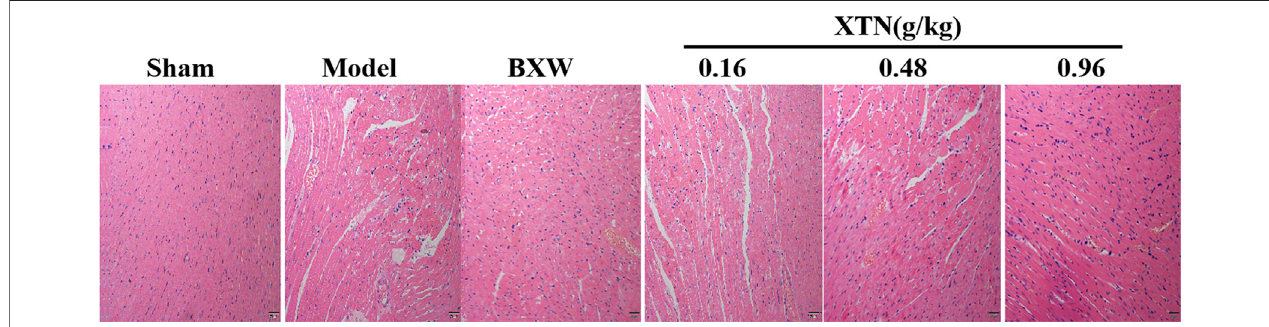
FIGURE 6 | Results of HE staining for cardiac tissues of rats in each group ( × 200).